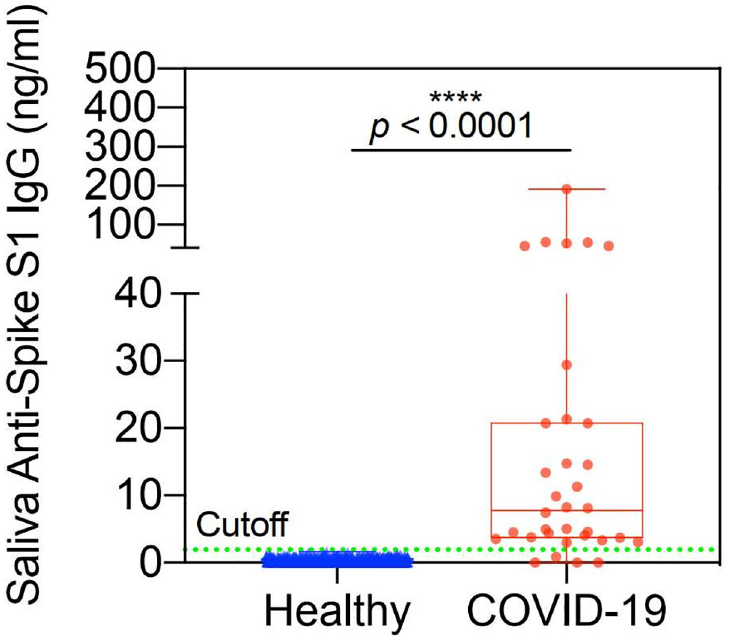
Fig 7. Amperial ™ detection of anti-Spike S1 IgG in saliva of COVID-19 (n = 34) and healthy subjects (n = 667). Green dashed line indicates 5 SD reference range cutoff.